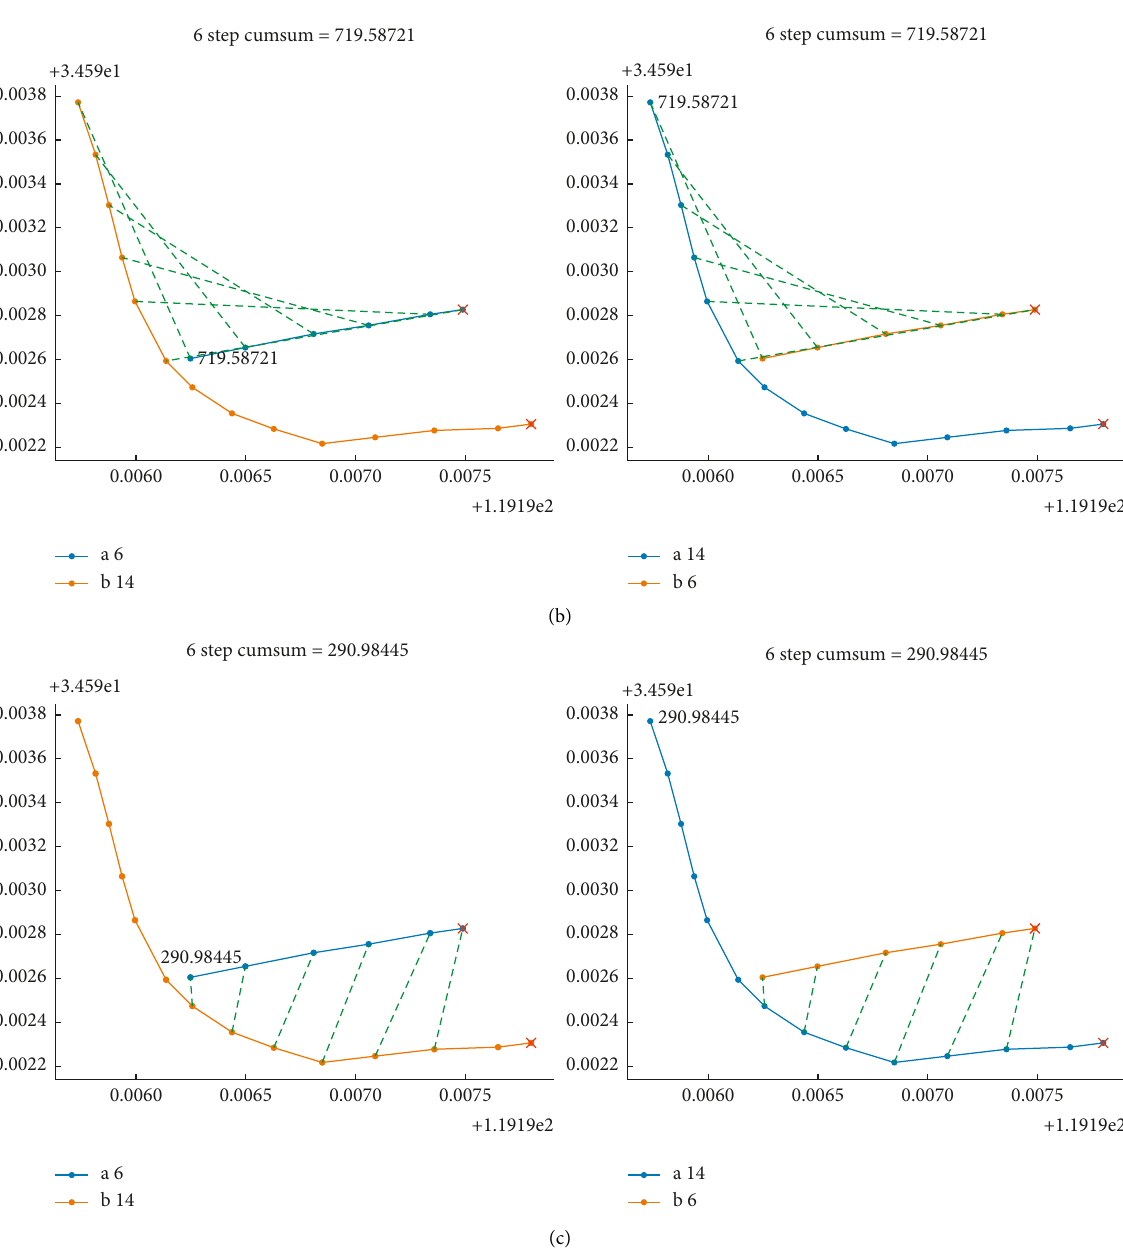
Figure 7: Symmetric generalized DTW for boundary condition. (a) OE. (b) OB. (c)